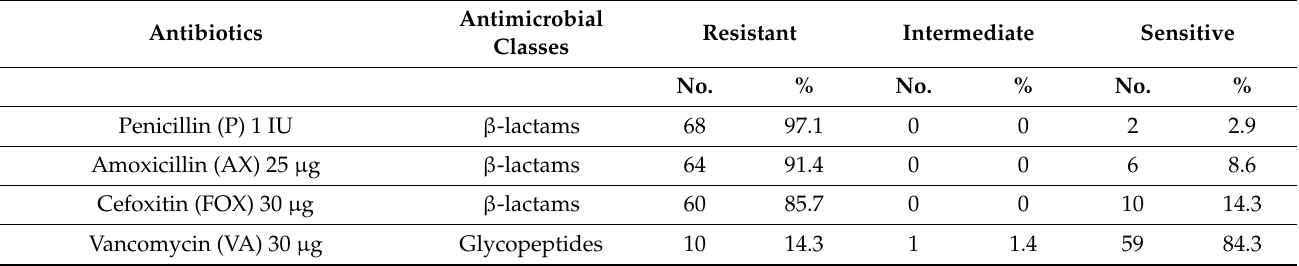
Table 3. Antimicrobial resistance of the CPS